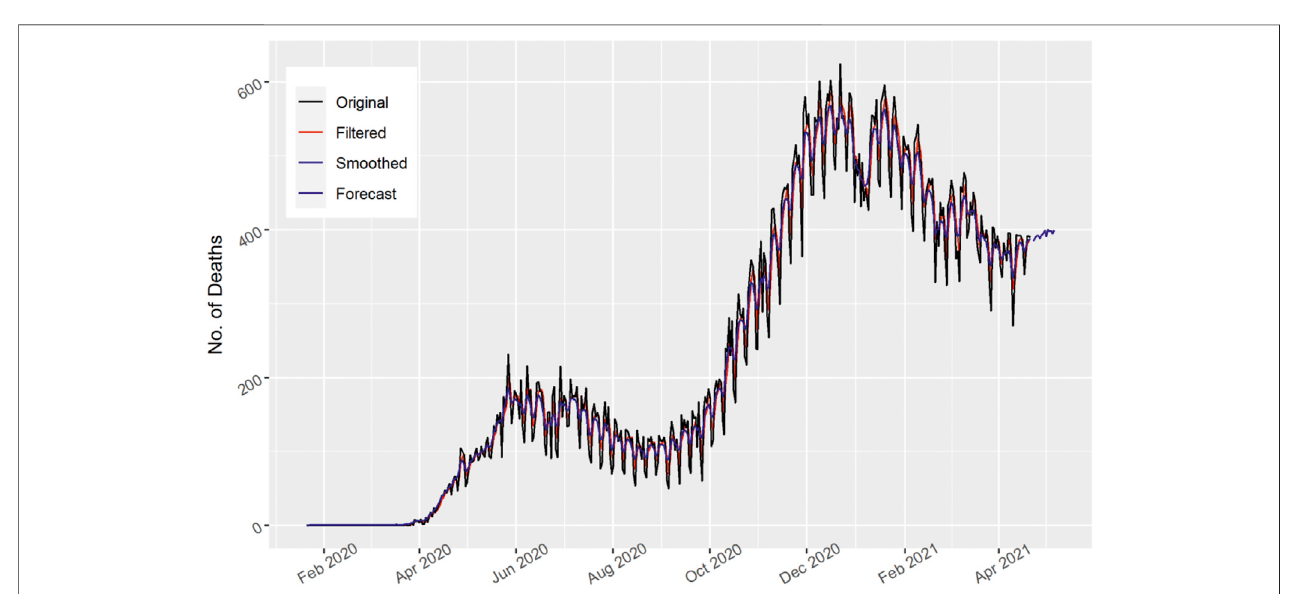
FIGURE 8 | Number of daily death cases in